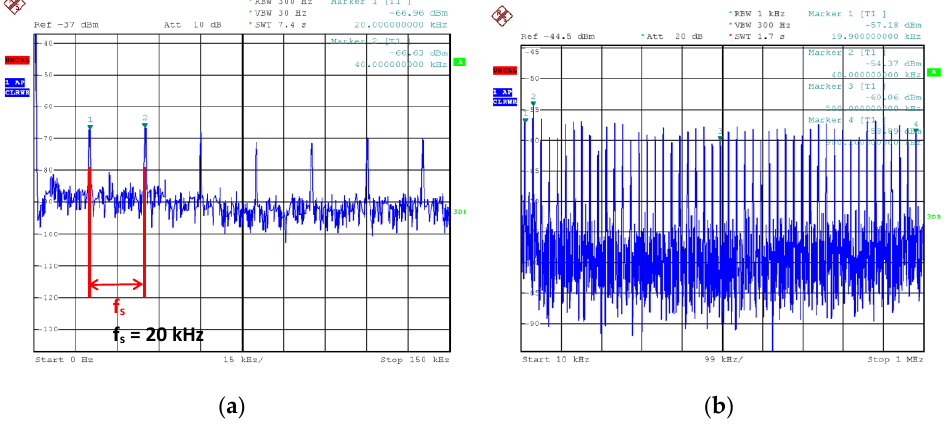
Figure 3. Power electronics electromagnetic interference (EMI): ( a ) conductive; ( b ) radiative.